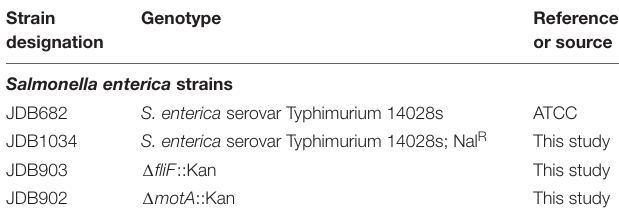
TABLE 1 | List of